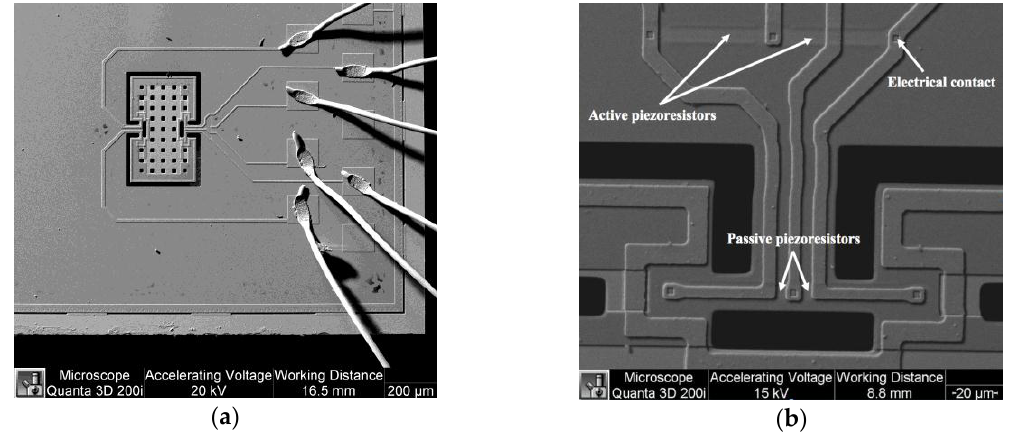
Figure 10. SEM image of a MEMS magnetic field device with piezoresistive sensing: ( a ) Silicon resonator and aluminum loop; ( b ) Wheatstone bridge with four piezoresistors [27]. Reprinted with permission from [27]. Copyright© 2015, Elsevier B.V.